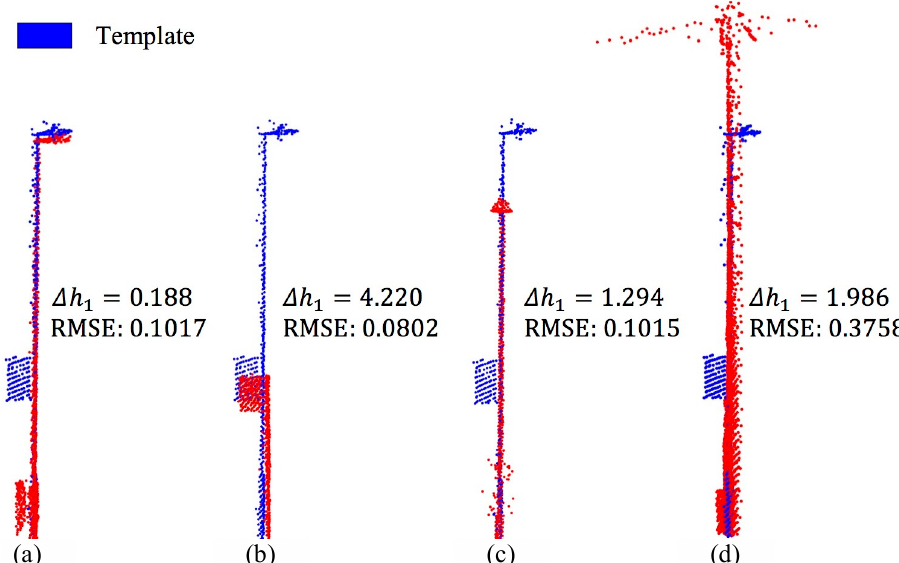
Figure 11. Illustration of the results for three-dimensional (3D) shape matching of poles in Data I (the template was illustrated in Figure 8). ( a ), ( b ), ( c ) and ( d ) are the classified poles of a street lamp, a traffic sign, a street lamp and a utility pole, respectively.